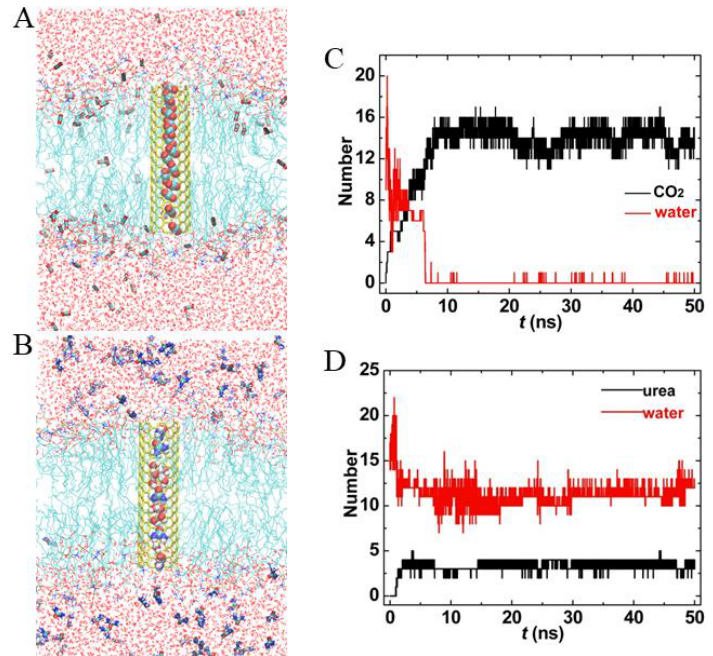
Figure 7. The transport properties of (7,7) PCNT in the lipid bilayer. ( A , B ) Snapshots at t = 50 ns, only half of the tubes are shown to highlight CO 2 and urea molecules in the PCNT hollow channels. ( C , D ) Number of water, CO 2 , and urea within PCNT as a function of simulation time.